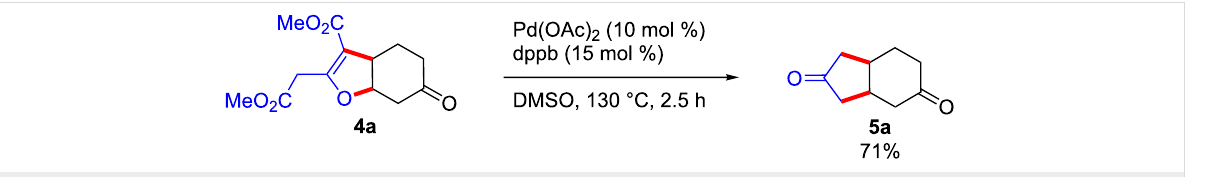
Scheme 6: Decarboxylative rearrangement of 4a into 5a